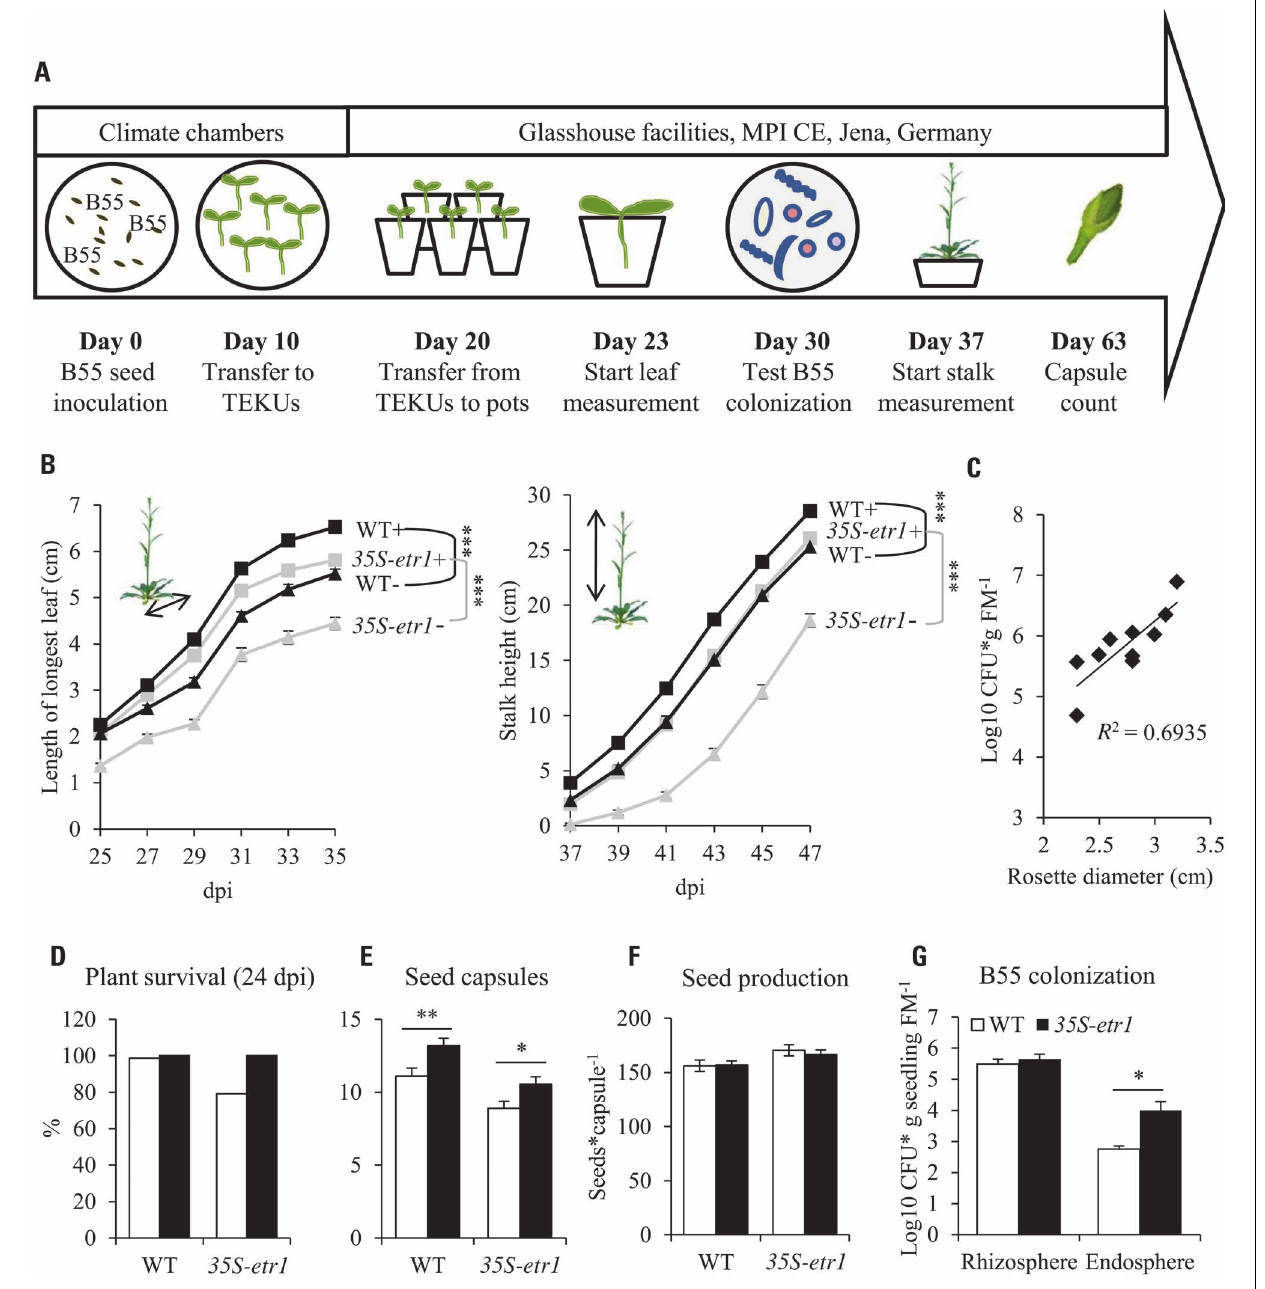
for (G) , white bars represent control treatments, black bars, B55-inoculated plants (PLSD test of an ANOVA between mock- and B55-inoculated plants: * P < 0.05; ** P < 0.01; *** P < 0.001). dpi, days post infection; CFU, colony forming unit; FM, fresh mass; n.d., not detected. n = 20 for (B,F) ; n = 10 for (C) ; n > 80 for (D) ; n = 5 for (E) .